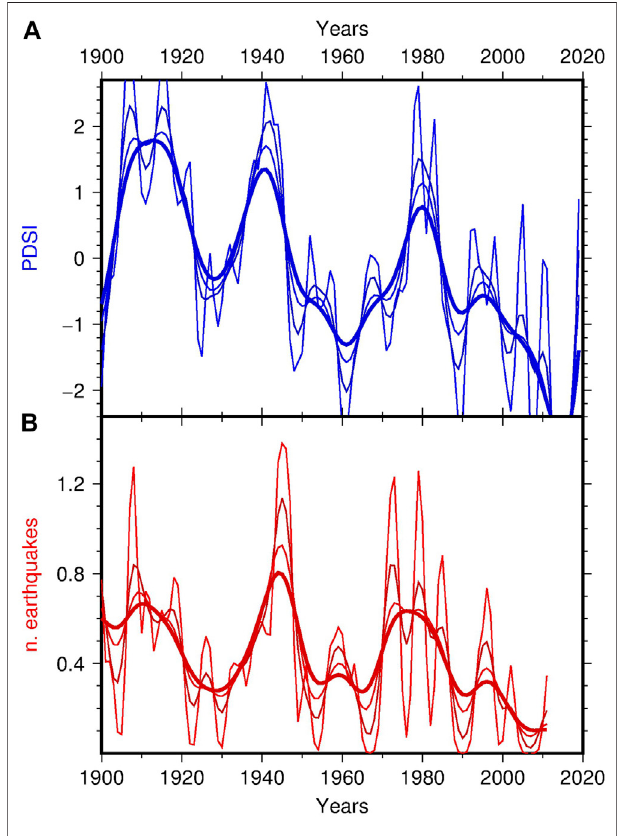
FIGURE 7 | Curves obtained for different choices of the smoothing parameter h (from 1 to 4 years). (A) kernel regression of PDSI averaged over the climate zones 6 and 7; (B) kernel estimation of the time density of earthquakes in Southern California.